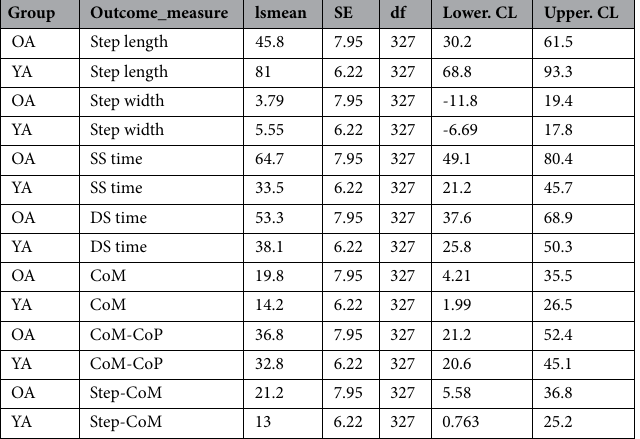
Table 3. Split Steps to Plateau Posthoc comparisons: estimated 95% confidence intervals for % (cid:31) steps to the plateau for the split condition [lmer Eq. (1)]. Confidence intervals that do not overlap reflects a significant difference between them.